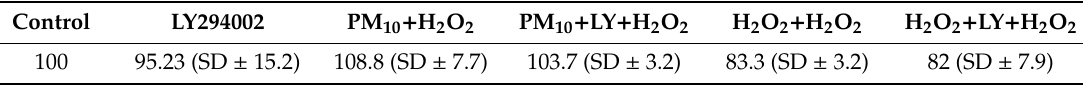
Table 1. Cell viability of lung epithelial A549 cells exposed to outdoor particulate matter with aerodynamic size ≤ 10 µ m (PM 10 ) and H 2 O 2